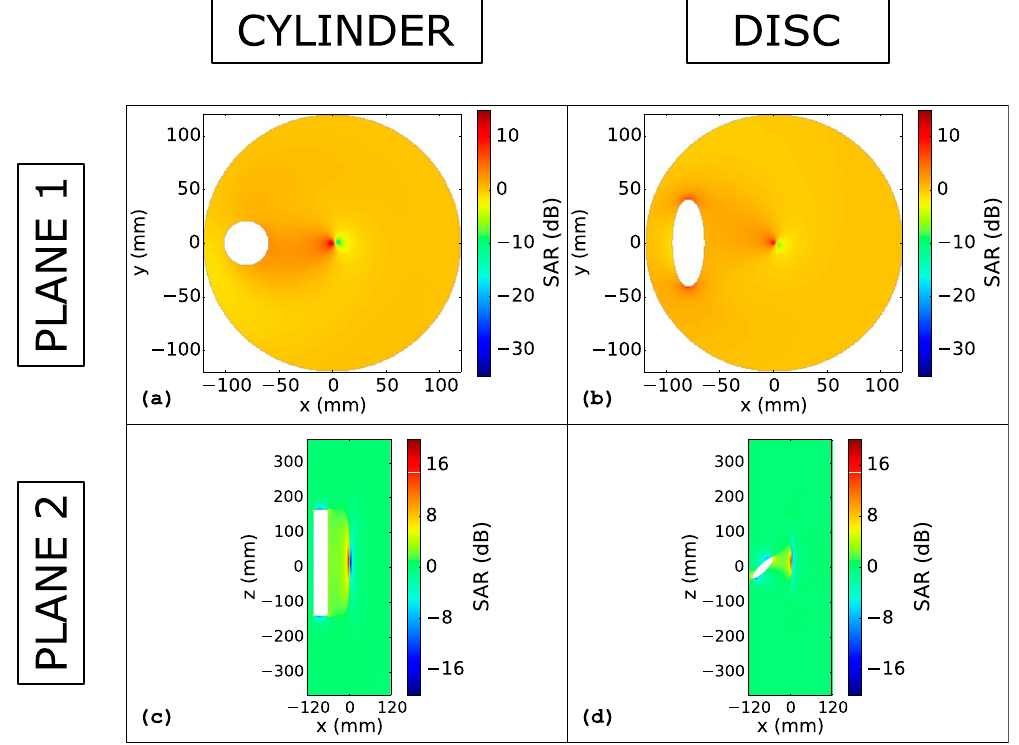
Figure 7. SAR: Lateral coated cylinder & lateral coated disc. Ratio between the SAR distribution with the coated metallic cylinder ( a ),( c ) and disc ( b ),( d ) and the one without any object. The figures refer to the objects positioned in a lateral side of the phantom ( − 80 mm from the phantom centre). Figures ( a ) and ( b ) refer to the transverse plane that cuts the object in two equal parts along the longitudinal direction. Figures ( c ) and ( d ) refer to the longitudinal plane that cuts the phantom in two equal